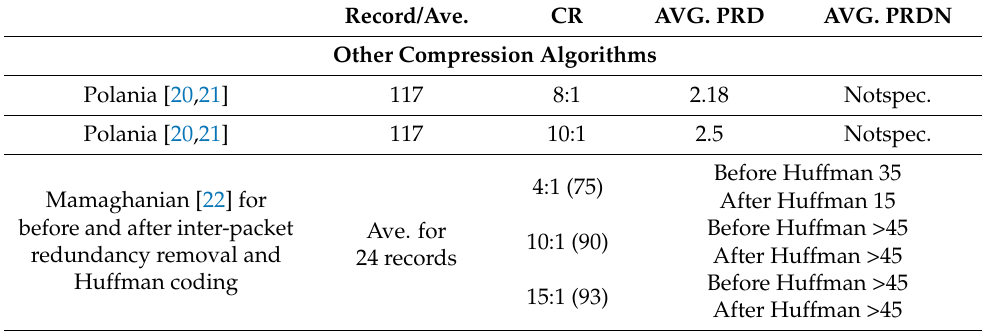
Table 10. Average values for 24 records and 117 record for other compression algorithms.